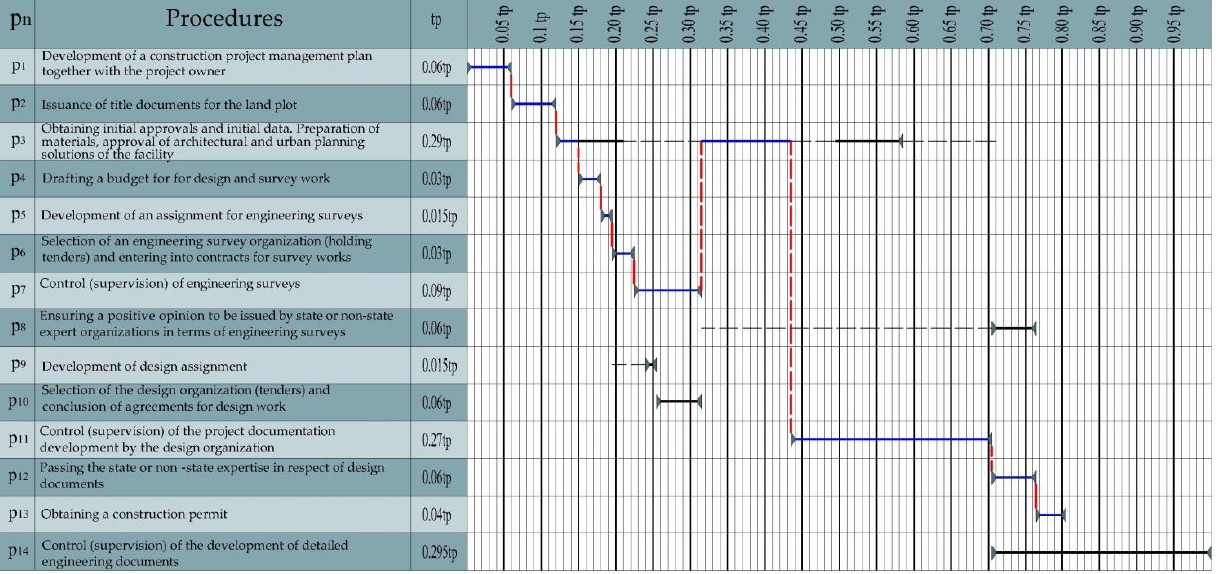
Figure 11. Organizational and management model of the rational combination of procedures at the stages of pre-project preparation and design development in linear form.